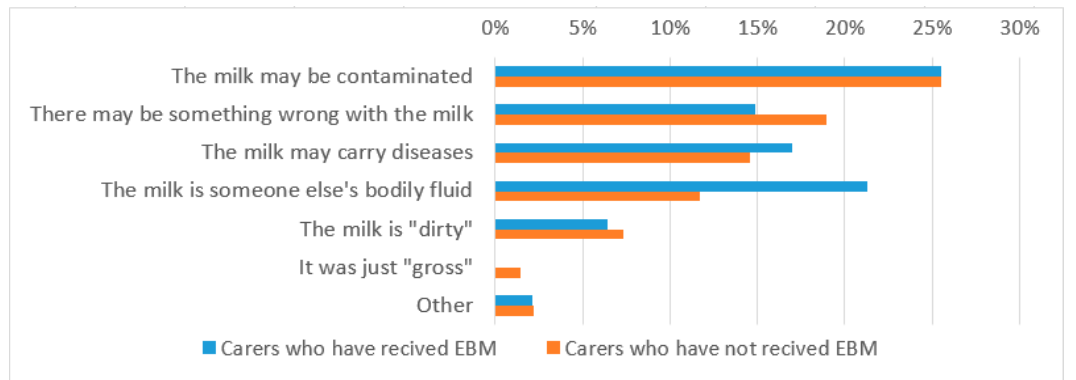
Figure 2. Percentage of carers concerned about handling of someone else’s breast milk.